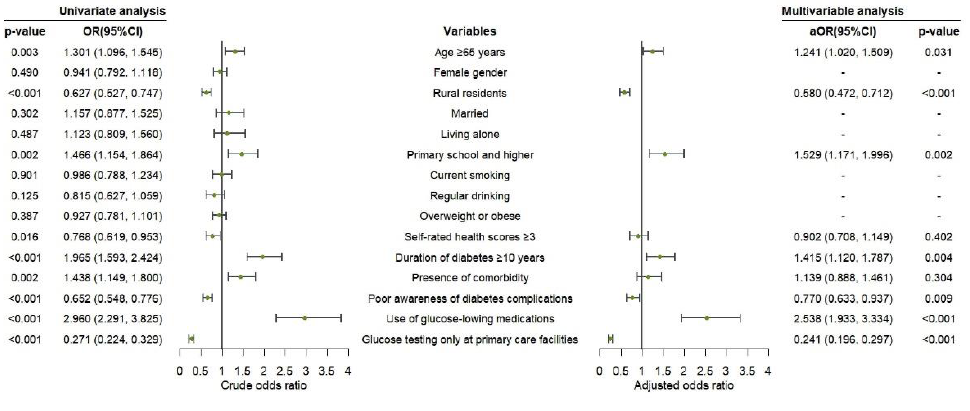
Figure 3. Logistic regression analysis on factors associated with regular blood glucose monitoring among T2DM patients at moderate to high CV risk.